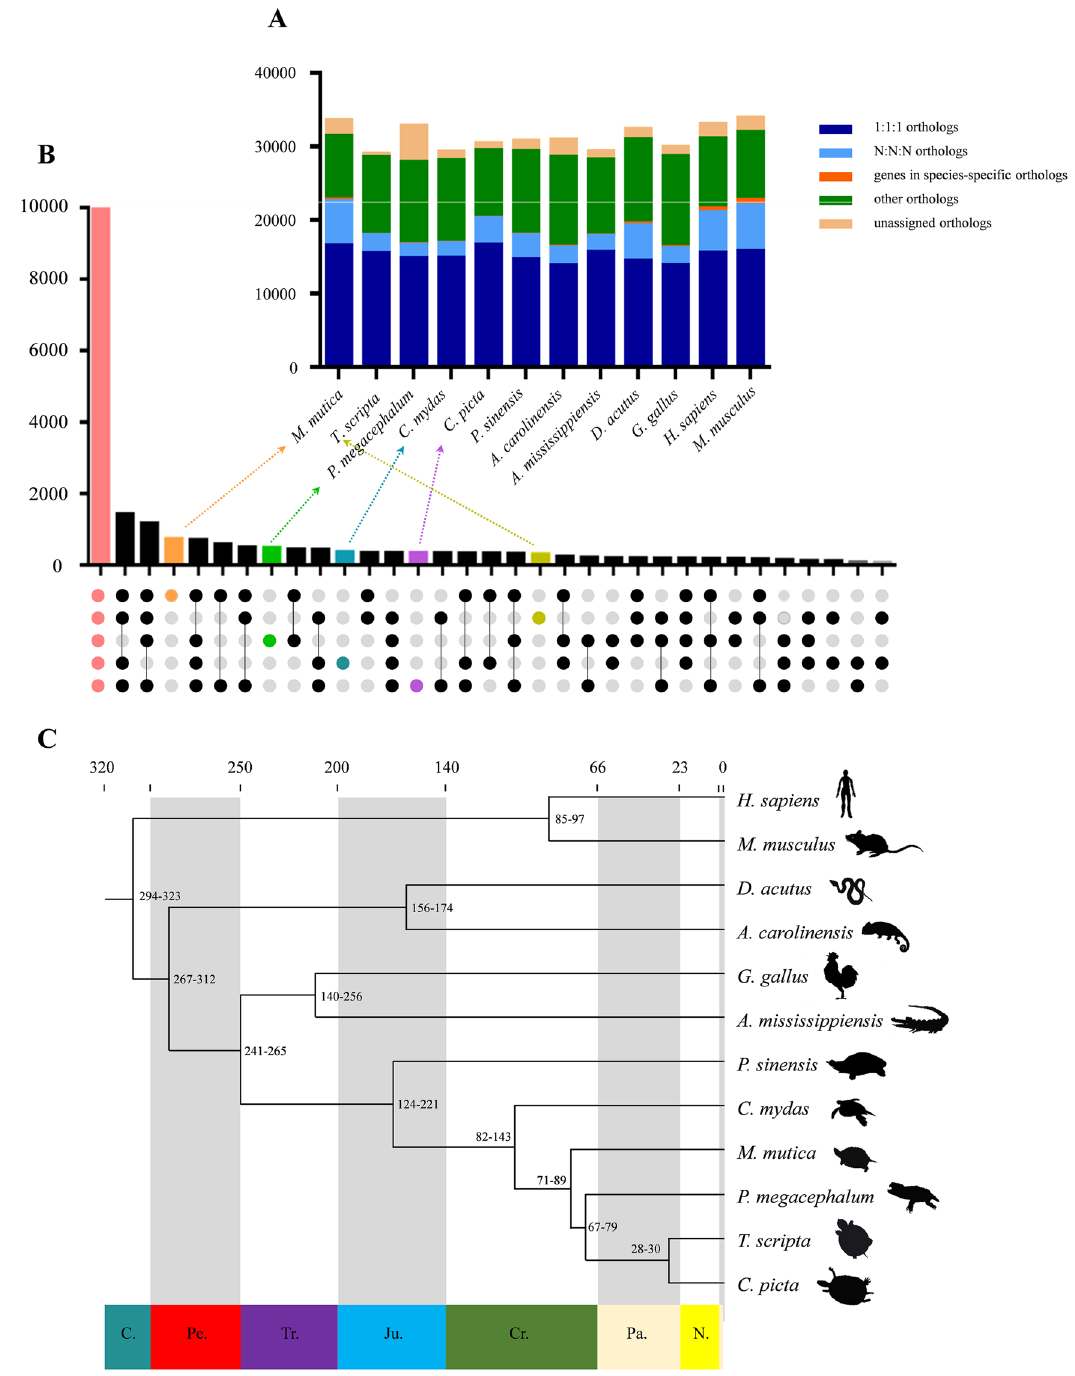
Figure 4. Gene family comparisons and phylogenetic analysis. ( A ) Orthologous gene families between the Asian yellow pond turtle and the other 11 vertebrates. 1:1:1 orthologs represent one copy genes in each species. N:N:N orthologous represent genes with multiple copies. ( B ) The UpSet plot of gene families in 5 turtle genomes shows shared (red), M. mutica -specific (orange), P . megacephalum -specific (green), C . mydas -specific (blue), C . picta -specific (purple), and T. scripta -specific (yellow) gene families. ( C ) Phylogenomic tree with the estimated divergence time among 12 vertebrates. The numbers on the branch represent the estimated divergence time with 95% confidence intervals. The number on the bottom of the tree is the geological time, and the number at the top of the tree is the absolute age, in millions of years, defined by the shadow of each geological period. C., Cambrian; Pe., Permian; Tr., Triassic; Ju., Jurassic; Cr., Cretaceous; Pa., Paleogene; N.,